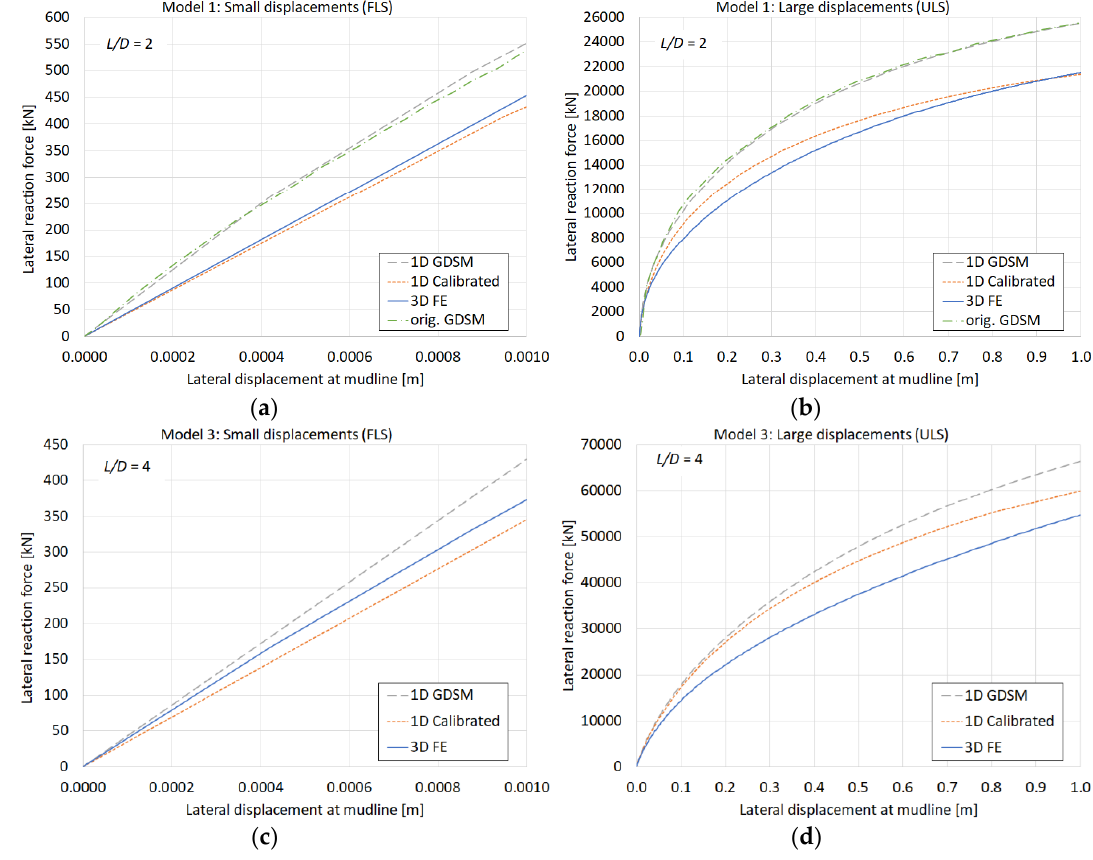
Figure 4. Load-displacement curves for Model 1 ( a,b ) and Model 3 ( c,d ) as listed in Table 3. Results from the other models are available in Appendix